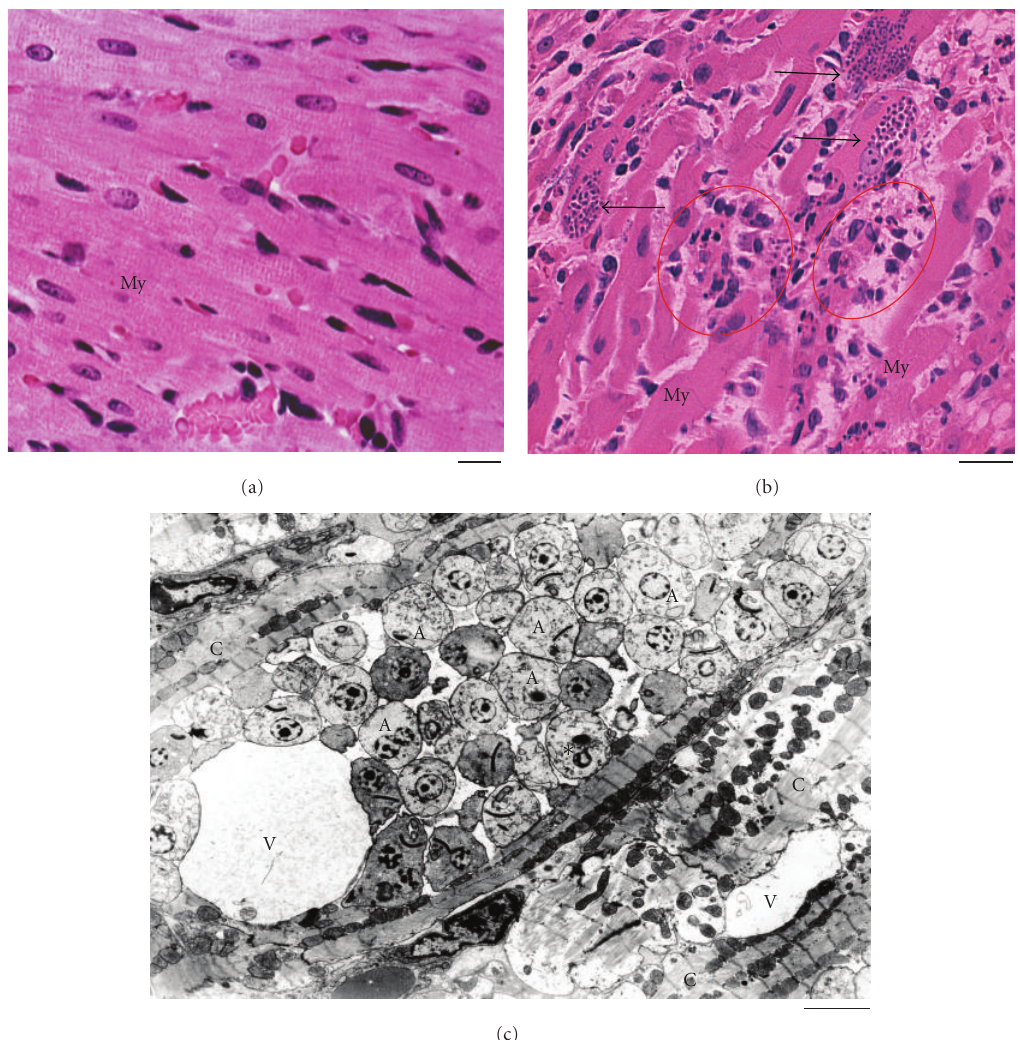
Figure 2: Morphological aspects of the heart from noninfected and infected rats at 12 days of infection with Trypanosoma cruzi . (a) Histological view of the myocardium from an uninfected rat. In (b), nests of amastigotes (arrows), the intracellular form of the parasite, and inflammatory processes (circles) characterized by predominance of mononuclear cells are observed in the myocardium (My). Semi-serial 5 μ m-thick sections of the heart were cut, stained by haematoxylin and eosin and examined for qualitative evaluation of the inflammatory and degenerative processes and quantification of parasitism [8, 34]. In (c), an electron micrograph of a parasitized cardiomyocyte (c) showing vacuoles (V) and many amastigotes (A). Data are representative of three independent experiments. Four to six rats per group. Panel (a) was reprinted from [9] with permission. Scale bar, 15 μ m (a, b); 1 μ m